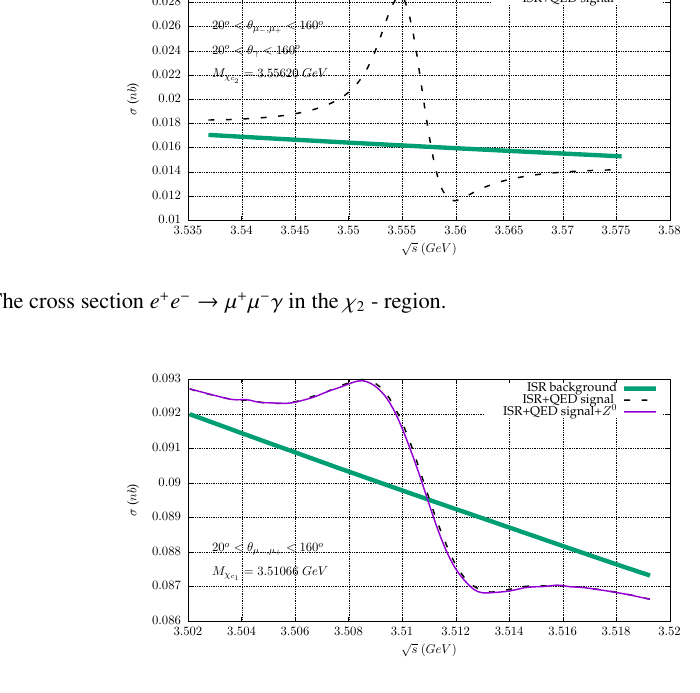
µ + µ − γ in the χ 1 - →